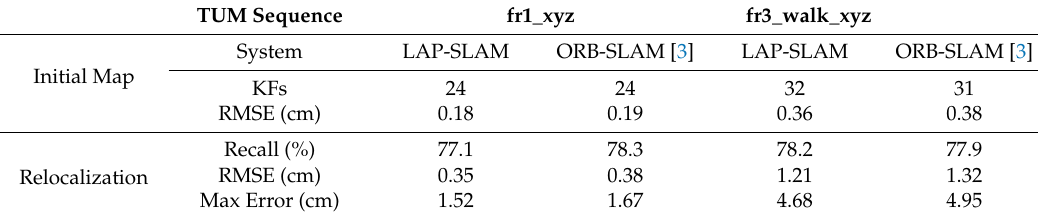
Table 3. Results of the relocalization experiments.